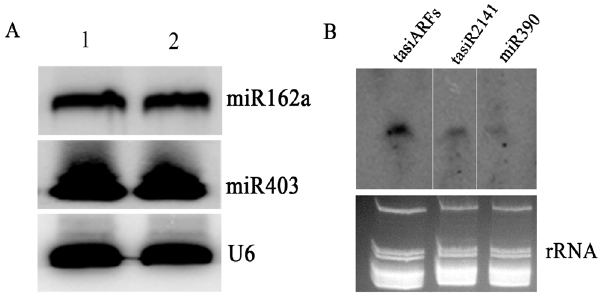
Figure 3. Experimental validation of papaya microRNAs by Northern blot assays. (A) Northern blot assays of papaya miR403 and miR162a each using 100 m g of LMW RNAs. U6 snRNA hybridization was used as a loading control. (B) Northern blot assays of papaya tasiARFs, tasiR2141 and miR390 based on sequence homology using 100 m g of LMW RNAs. Ethidium bromide-stained rRNAs are shown as a loading